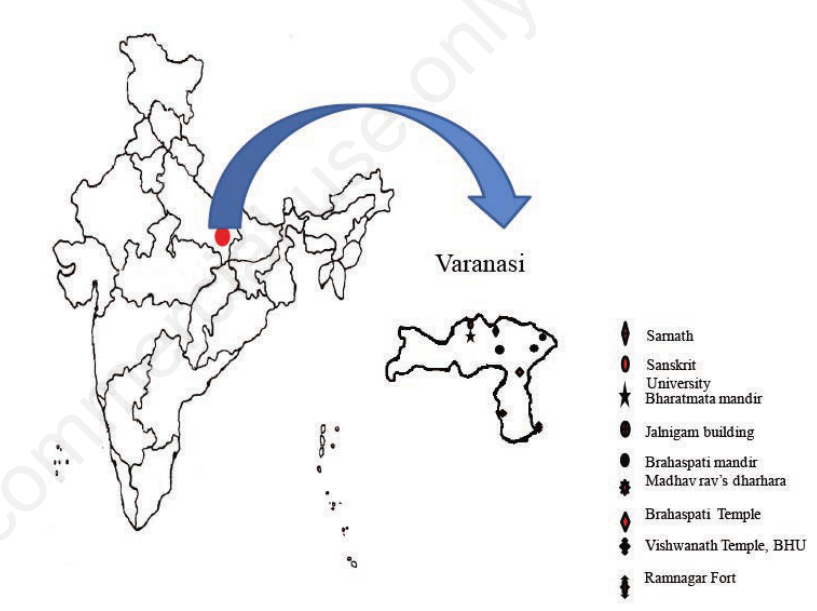
Table 1. Cyanobacteria colonizing surface of different historical monuments of Varanasi, India. Organisms Nostoc sp.